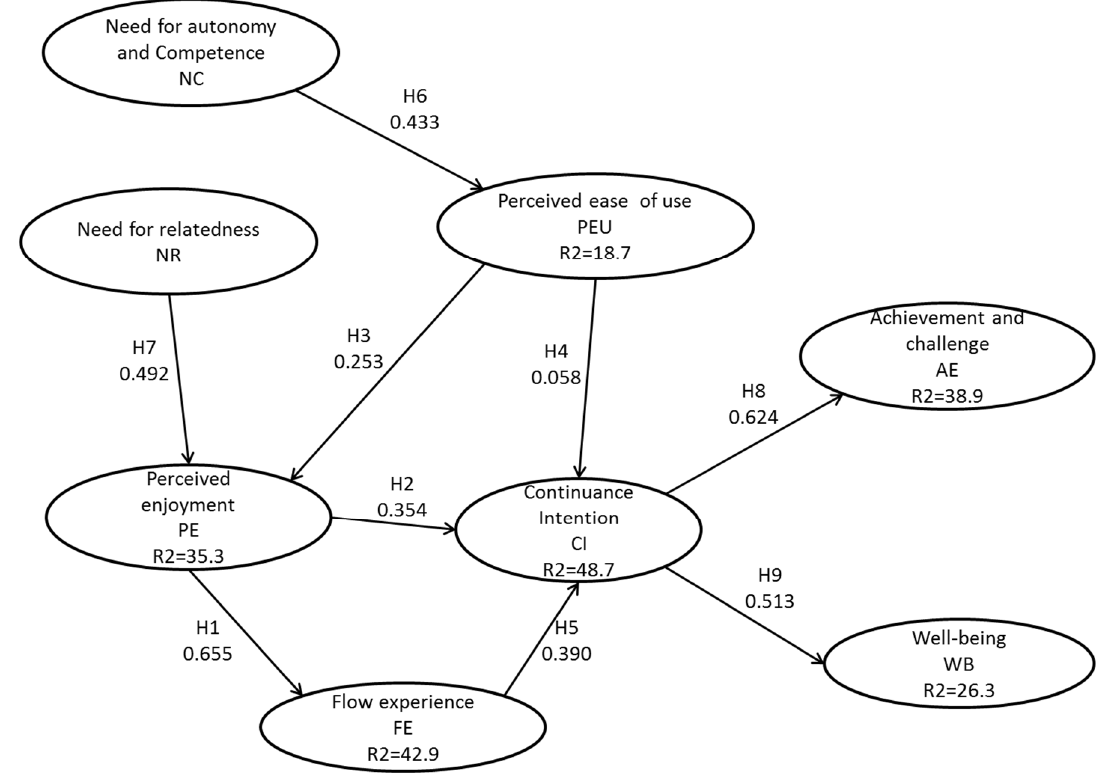
Figure 2. Path coefficient of the analysis.